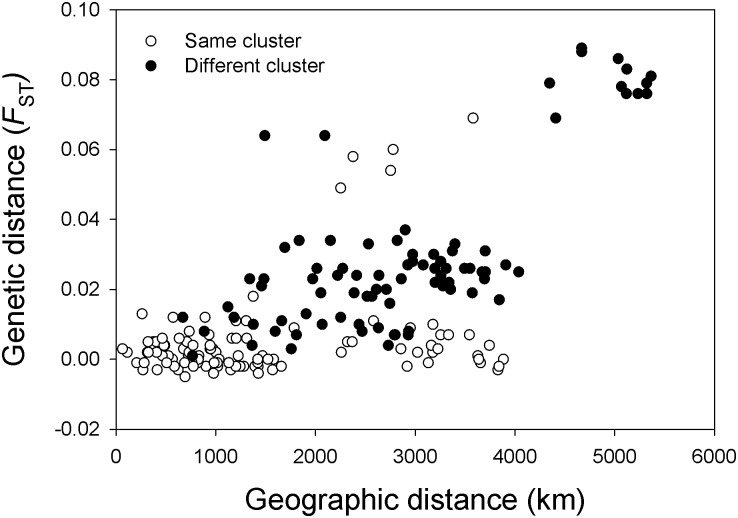
Pairwise genetic (F
ST) based on microsatellites and geographic distance values highlighting population pairs within the same cluster (blue dots) and in different clusters (orange dots).